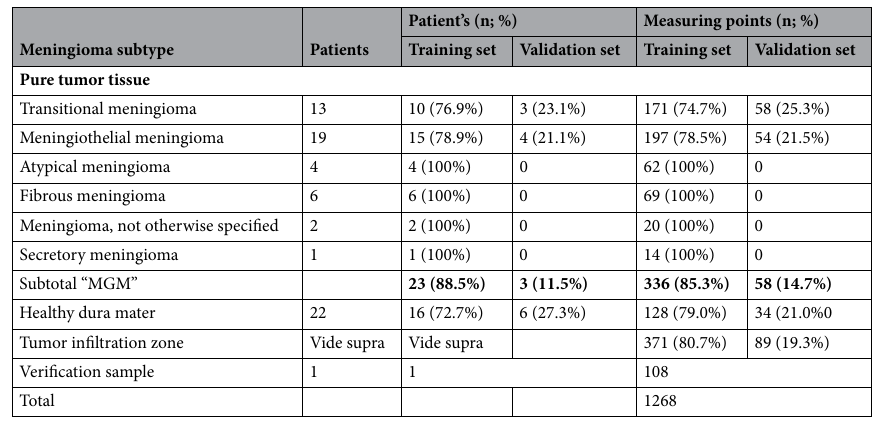
Table 1. Data overview. Three classes were defined: Unequivocal meningioma tumor tissue, healthy dura mater and tumor-infiltrated dura mater samples. The data was split up in a training and validation set. The percentages indicate the corresponding portions of samples and measuring points, subdivided in the different tissue types. Upper table part: Meningioma samples. Middle table part: Origin of the probed healthy dura mater samples. Lower table part: Meningioma-infiltrated dura mater samples. Closing line: Total numbers of patients, samples and measuring points. Notice that, the infiltration zone samples belong to patients that were already considered in the other classes. The kept out surgical-site-simulating verification sample was of atypical meningioma tissue origin and was used for the subsequent classifier mapping study. Significant values are in